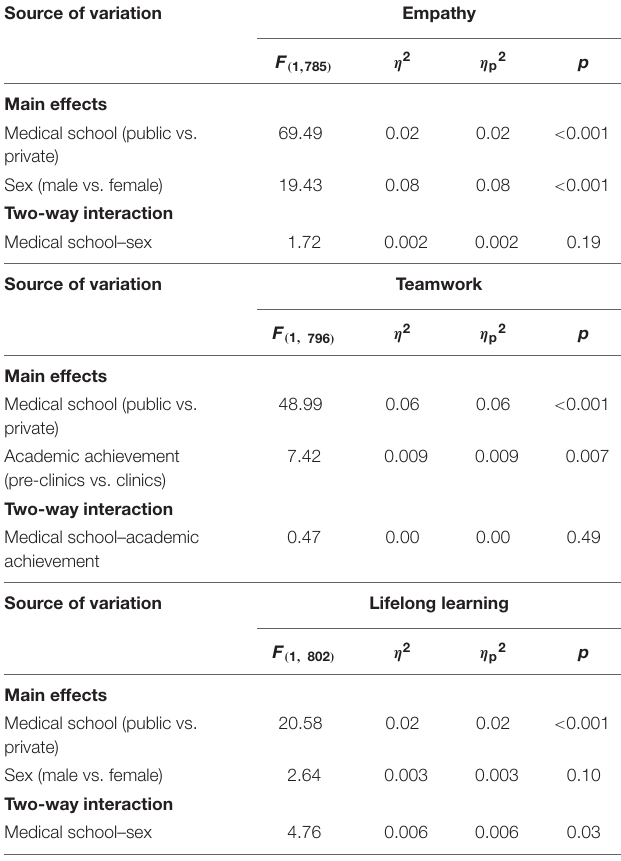
TABLE 3 | Two-way ANOVA of empathy, teamwork, and lifelong learning by medical school, sex, and academic achievement, as sources of variation. Source of variation